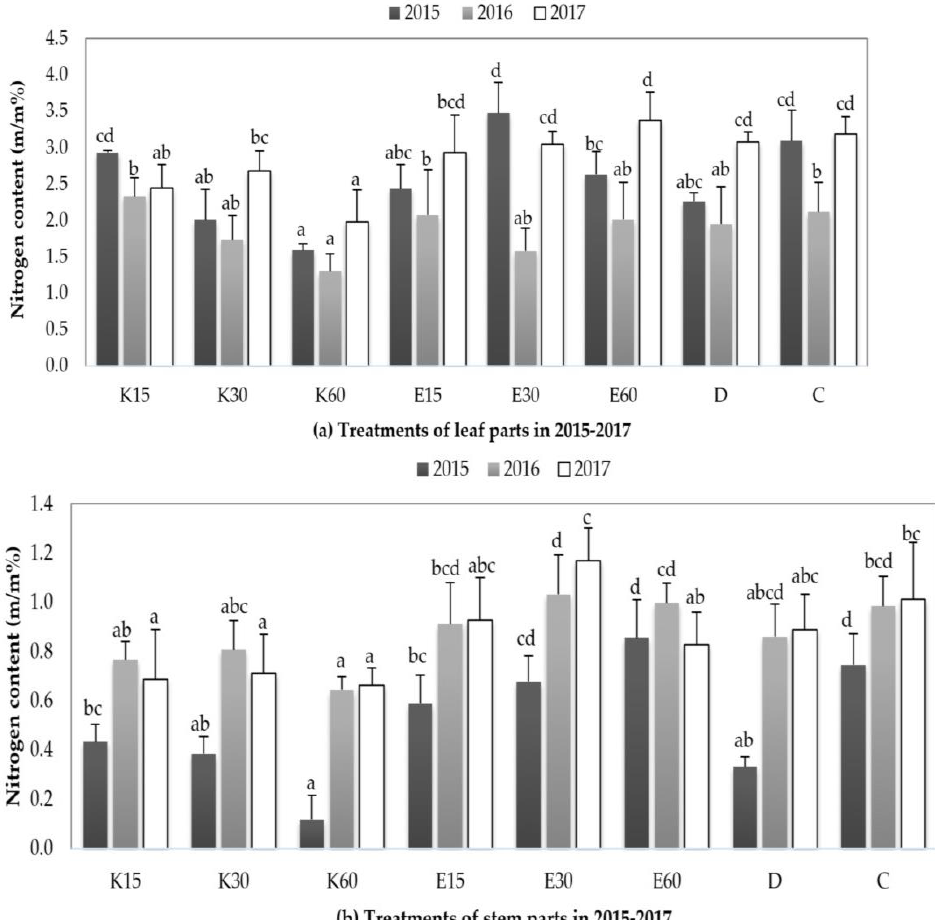
Figure 3. Nitrogen content values of leaf and stem parts from 2015 to 2017: ( a ) nitrogen content values of leaf parts in a year of 2015–2017; ( b ) nitrogen content values of stem parts in a year of 2015–17. Average nitrogen content data are presented from eight treatments. Results are means ± SD, n = 6. Treatments were compared annually. Different letters introduce significant differences among irrigation water qualities for the three vegetation season, confirming to the Tukey’s test at p ≤ 0.05.